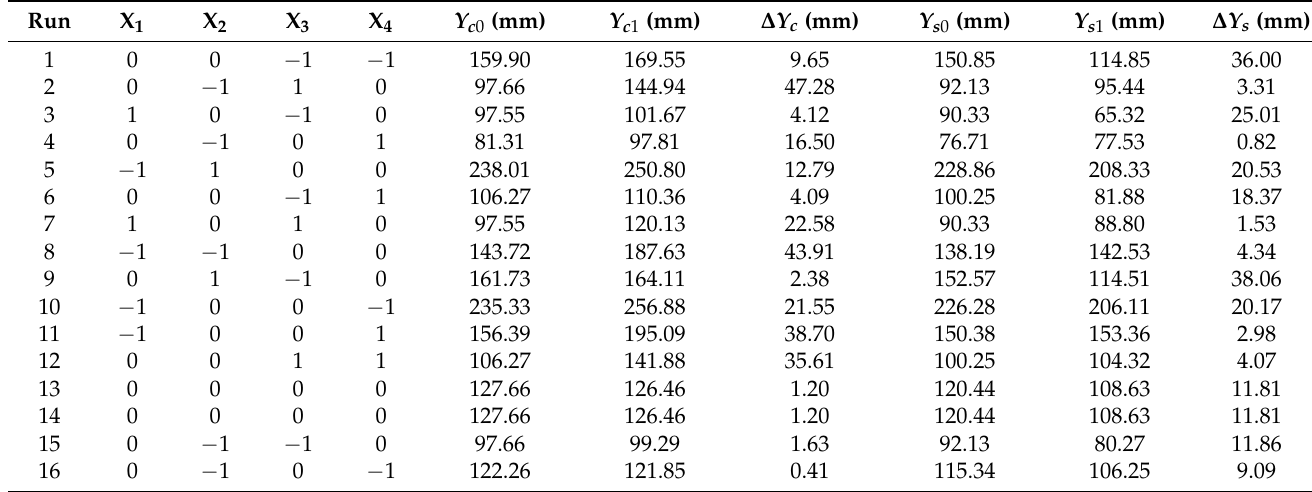
Table 3. Test arrangement and results of